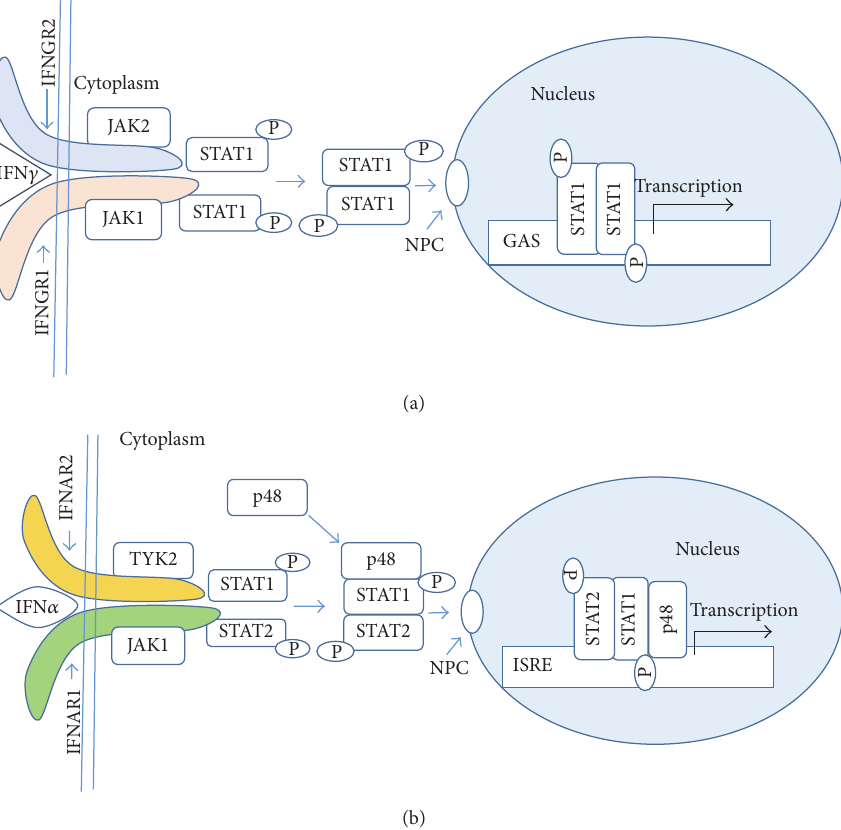
Figure 1: Canonical model of IFN 𝛾 (a) and IFN 𝛼 (b) signaling. (a) IFN 𝛾 cross-links the IFNGR1 receptor subunit that results in allosteric changes in receptor cytoplasmic domain, causing the movement of JAK2 from receptor subunit IFNGR2 to IFNGR1. The JAKs autophosphorylate and then phosphorylate IFNGR1 cytoplasmic domain. This results in binding, phosphorylation, and dimer formation of STAT1 𝛼 . The dimeric STAT1 𝛼 dissociates from receptor and undergoes nuclear translocation via an intrinsic NLS for specific gene activation. (b) IFN 𝛼 binding to its receptor subunit initiates a set of events that leads to activation of STAT1 𝛼 and STAT2 and formation of a complex of STATs and p48 (ISGF3) that is translocated to the specific promoter site. This model does not account for the epigenetic events nor does it explain the specificity of cytokine signaling. NPC, nuclear pore